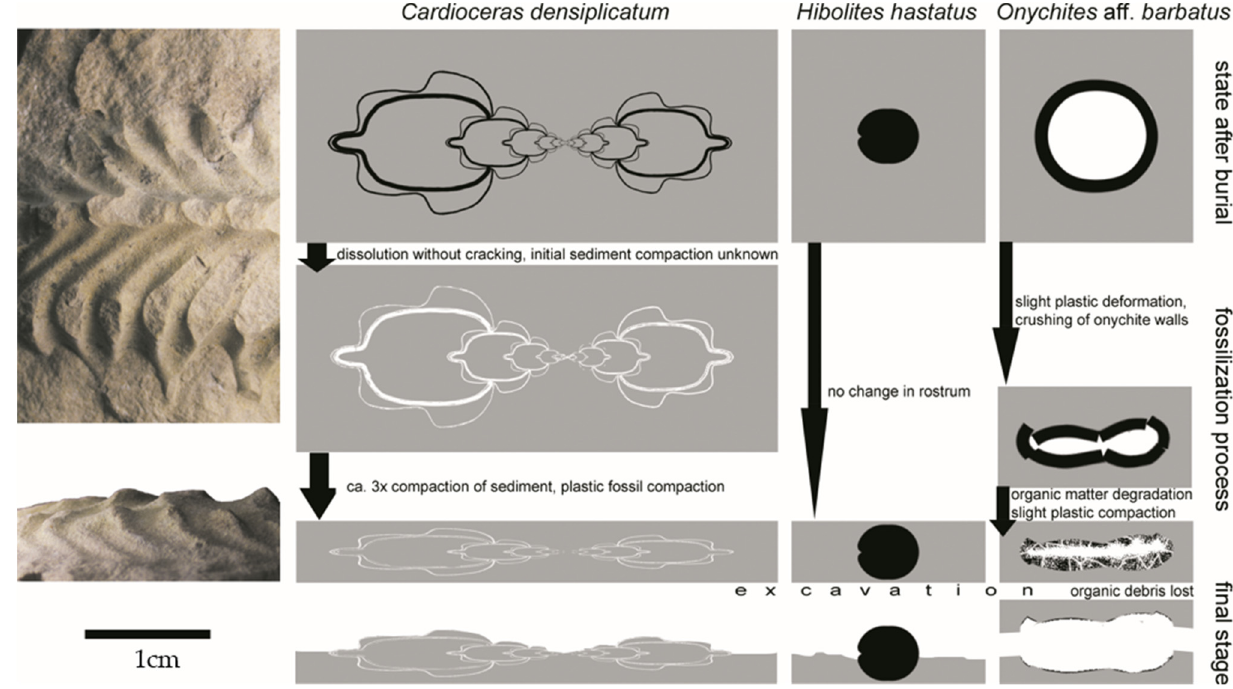
Figure 3. Comparison of taphonomies of ammonite (with photos of two specimens in orientations perpendicular and parallel to the bedding plane, scale bar 1 cm), belemnite rostrum, and examined onychites.